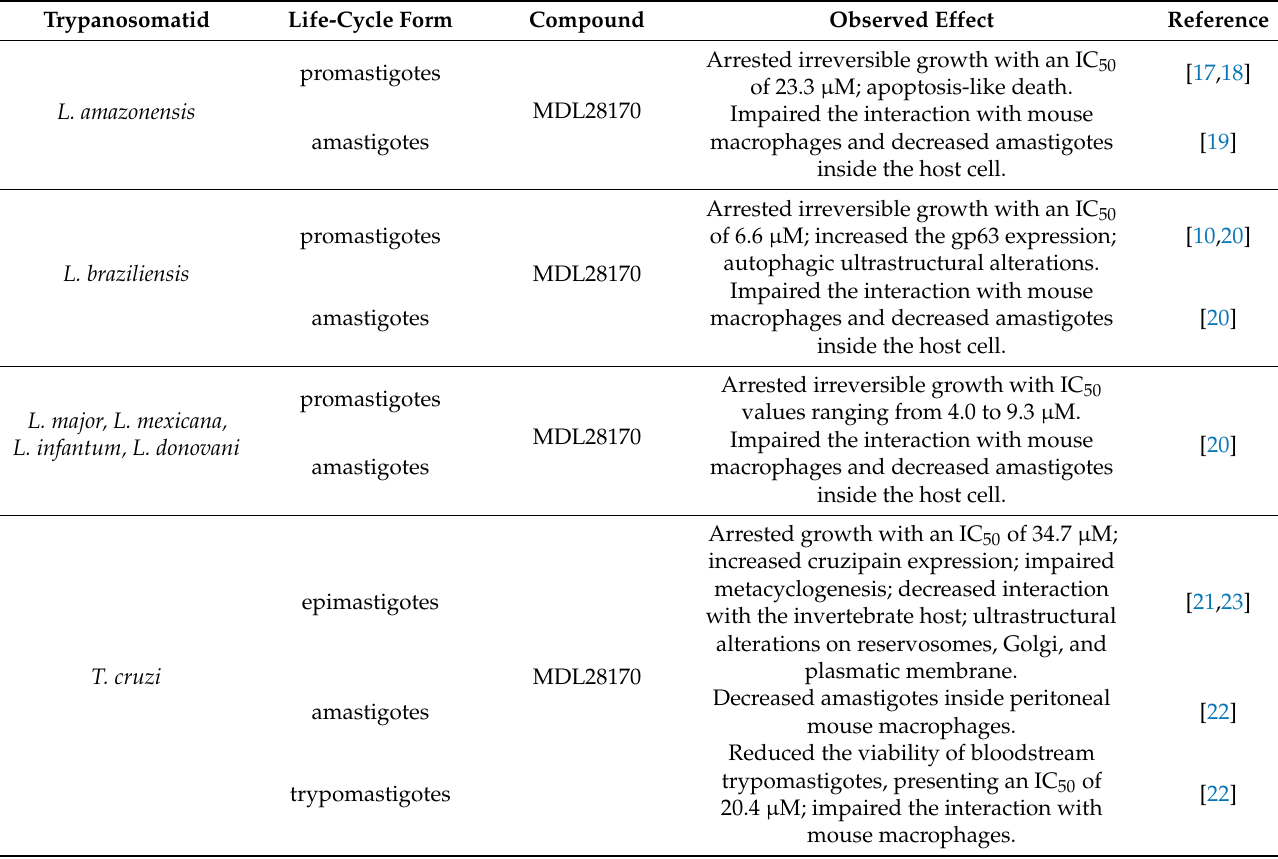
Table 1. In vitro effects of calpain inhibitors against trypanosomatid